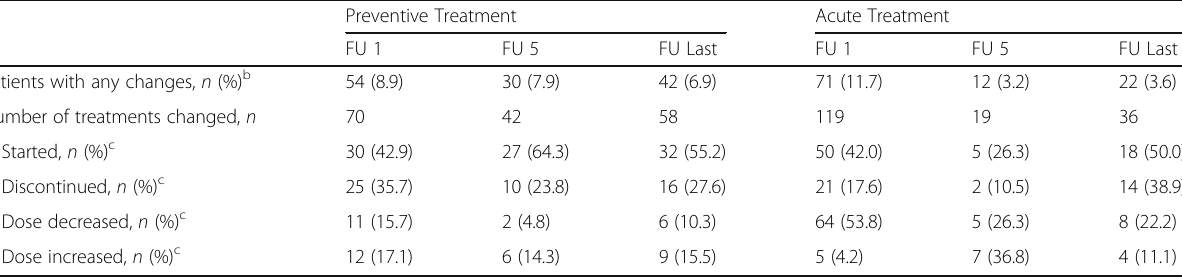
Table 4 Change in Acute and Preventive Treatments Between Visits a Preventive Treatment Acute Treatment